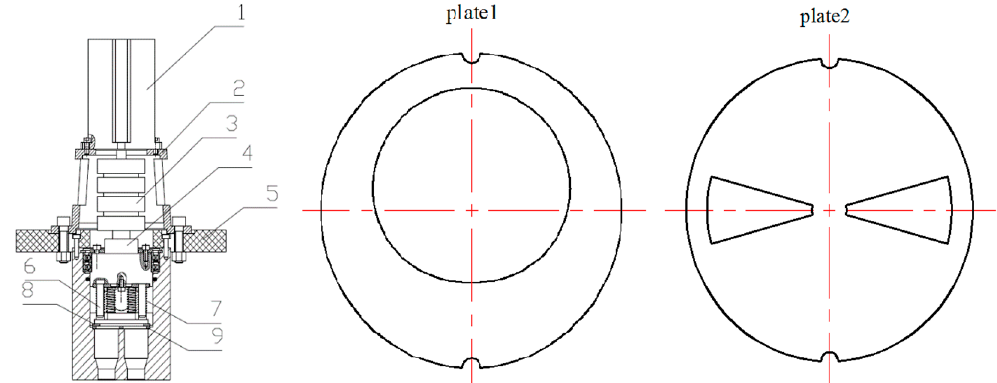
Figure 6. Cross-section of the shunting device. 1—86-step motor; 2—bell jar; 3—three-diaphragm coupling; 4—rotor; 5—fixed plate; 6—drive column; 7—spring; 8—plate 1; 9—plate 2.